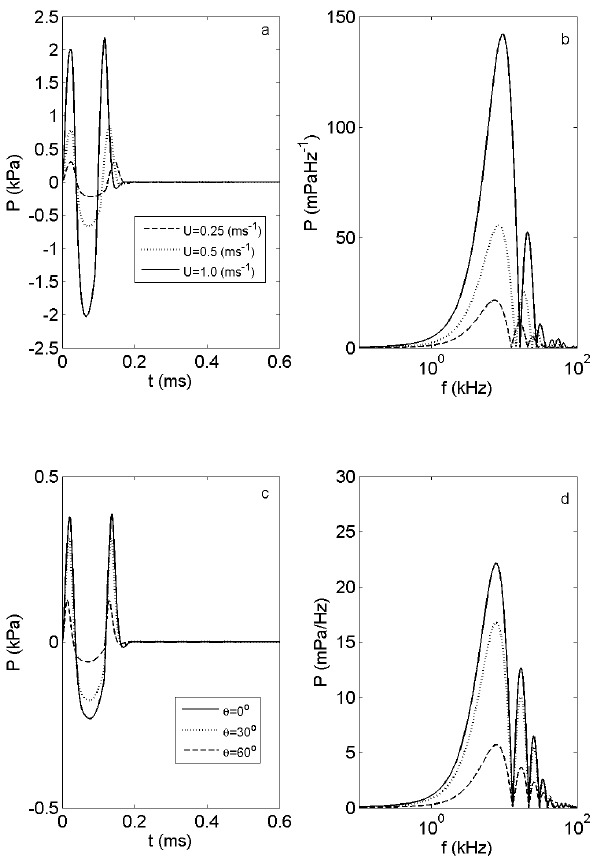
Figure 5. Calculations for the time domain waveform using Eq. (1) and the frequency spectrum using Eq. (2) for a = 0 . 0015m as the velocity, U , increased ( a and b ) and as the angle between the direc- tion of impact and the measurement position, θ , increased ( c and d ).